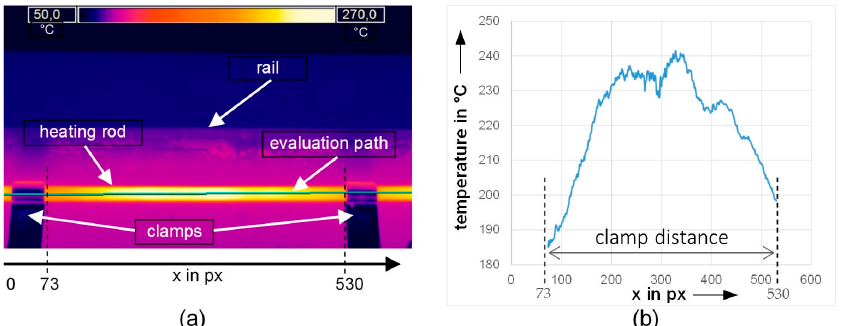
Figure 1. ( a ) Thermal image of heating rod and stock rail taken under laboratory conditions at an ambient temperature of 22 °C for a heating power of 300 W m − 1 and an emissivity of 0.87 that was reached by using a specific emissivity varnish; ( b ) related temperature at the heating rod along the green horizontal evaluation path dependent on the respective pixel in the thermal image.